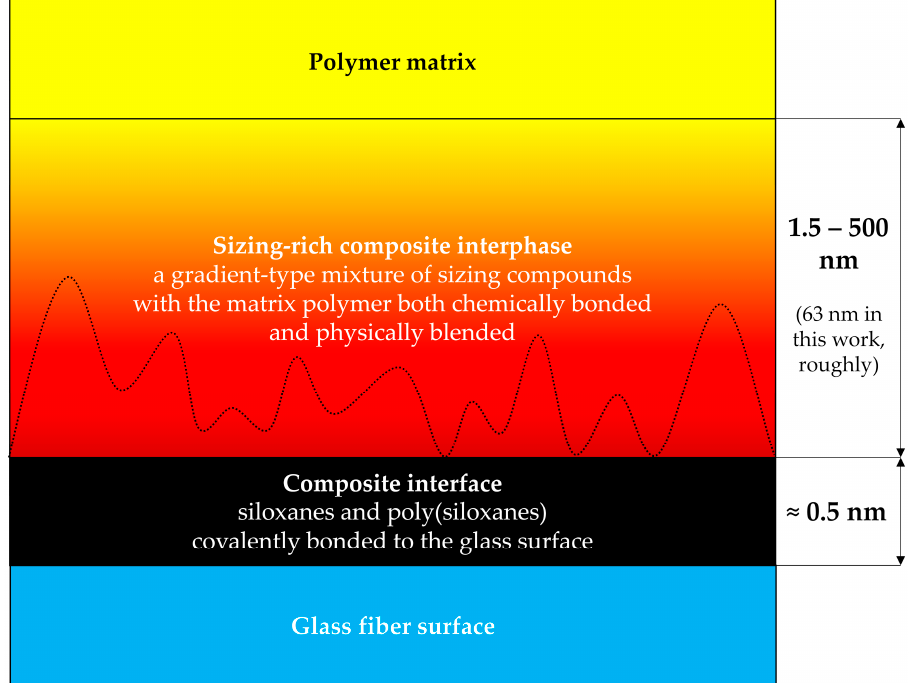
Figure 1. The concept of a polymer–siloxane–glass interphase, after [5]. The dotted line indicates that the sizing is rough